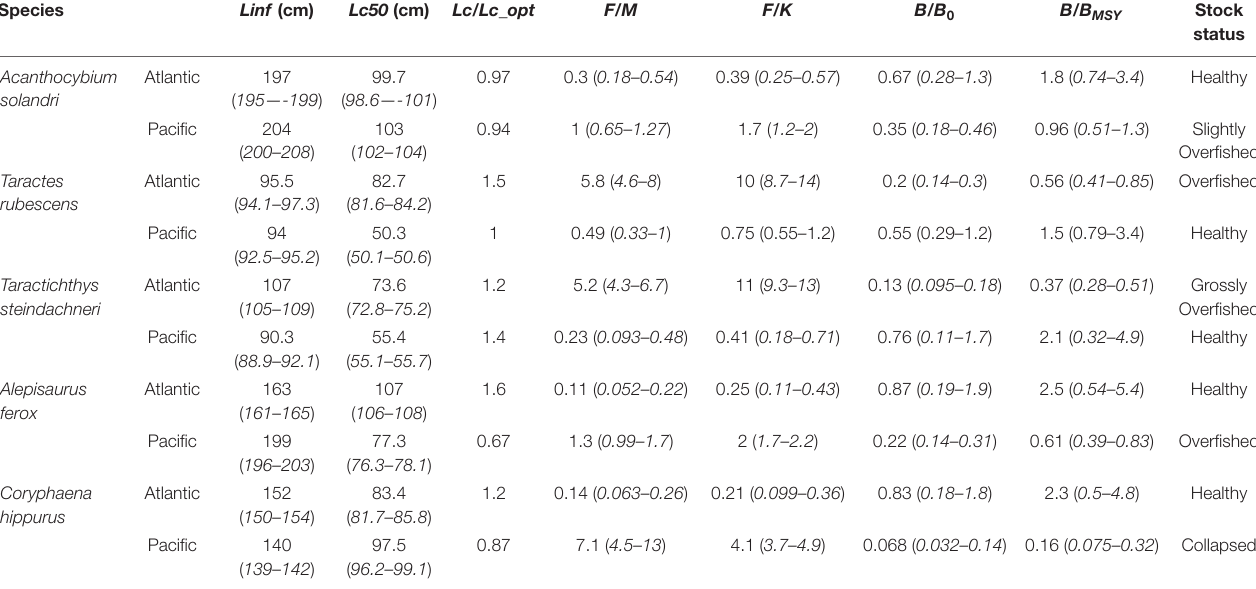
TABLE 2 | Fishery statuses of the five pelagic species assessed in the Atlantic and Pacific Oceans presented by LBB [ L inf , L c 50 and Lc/L c_opt , F/M, F/K, and B/B 0 and B/B MSY and their respective 95% confidence intervals (numbers in